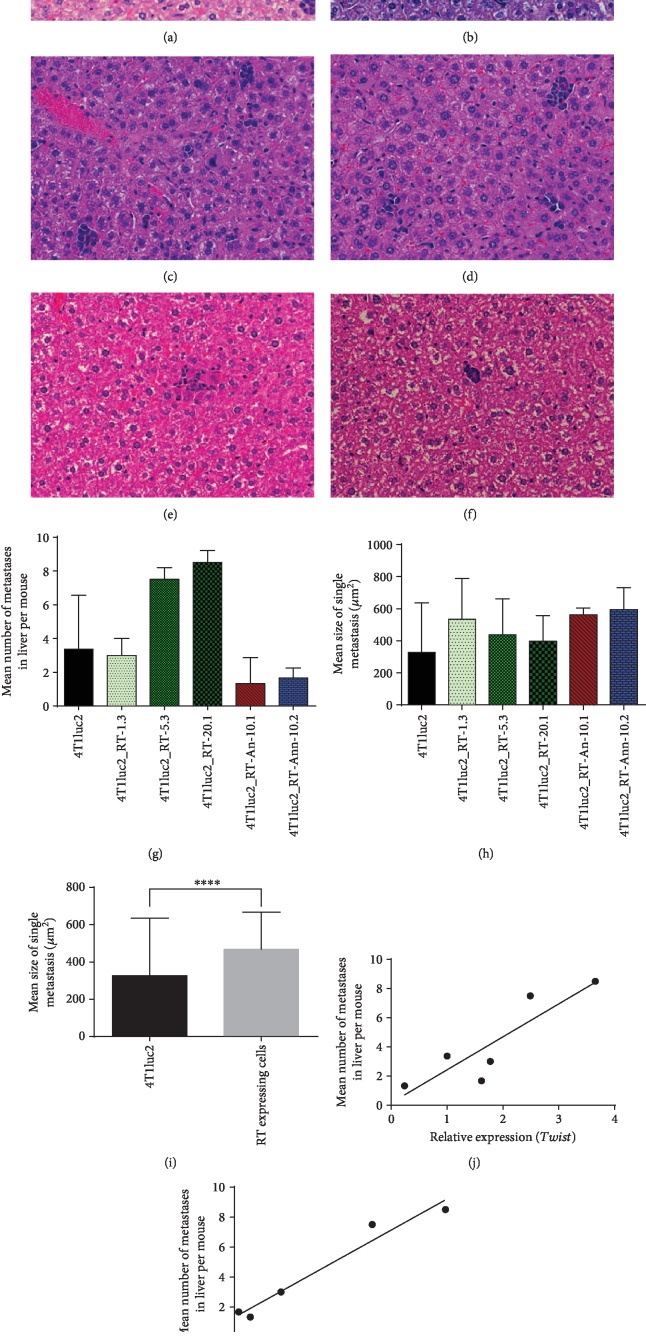
Histochemical characterization of the formation of metastases in the livers of BALB/c mice ectopically implanted with 4Tluc2 and derivative clones expressing variants of HIV-1 FSU_A reverse transcriptase (RT_A). H&E staining of liver sections of mice injected with 4T1luc2 and its RT-expressing subclones (×400): 4T1luc2 (a), 4T1luc2_RT-1.3 (b), 4T1luc2_RT-5.3 (c), 4T1luc2_RT-20.1 (d), 4T1luc2_RT-An-10.1 (e), 4T1luc2_RT-Ann-10.2 (f). Mean number (g) and size (h) of metastases. Mean size of liver metastasis formed by all RT_A-expressing clones compared to the parental 4Tluc2 cells (i). Correlations between the mean numbers of metastases in a mouse liver assessed by histochemical staining and the levels of expression by the respective 4T1luc2 clone of Twist (day 14 of cell culture) (j) and of RT_A variant per cell (k). Ten high-power fields per mouse (n = 3) were screened to assess the number of metastasis; their size was evaluated using NIS-Elements software (Nikon, Tokyo, Japan), both values were represented as mean ± SD. Expression level of Twist was normalized to the expression level of HPRT1 and represented as fold change compared to the level in the parental 4T1luc2 cells. Comparisons were done using the Mann-Whitney test, and correlations, using the Spearman correlation test. ∗p < 0.05, ∗∗p < 0.005, ∗∗∗p < 0.0005, and ∗∗∗∗p < 0.0001.